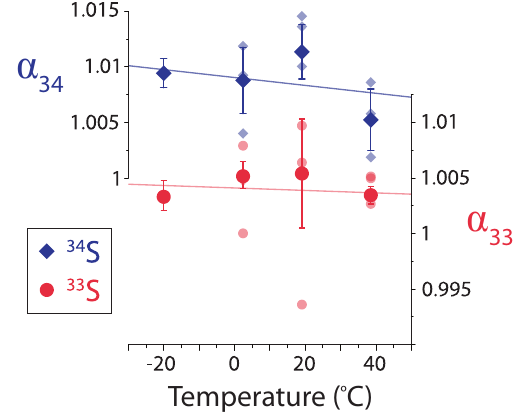
Fig. 10. Temperature dependent fractionation factors during the gas-phase oxidation of SO 2 by OH radicals. Pale points represent individual experiments while dark points with error bars are the av- erage and 1 σ error of the mean at each